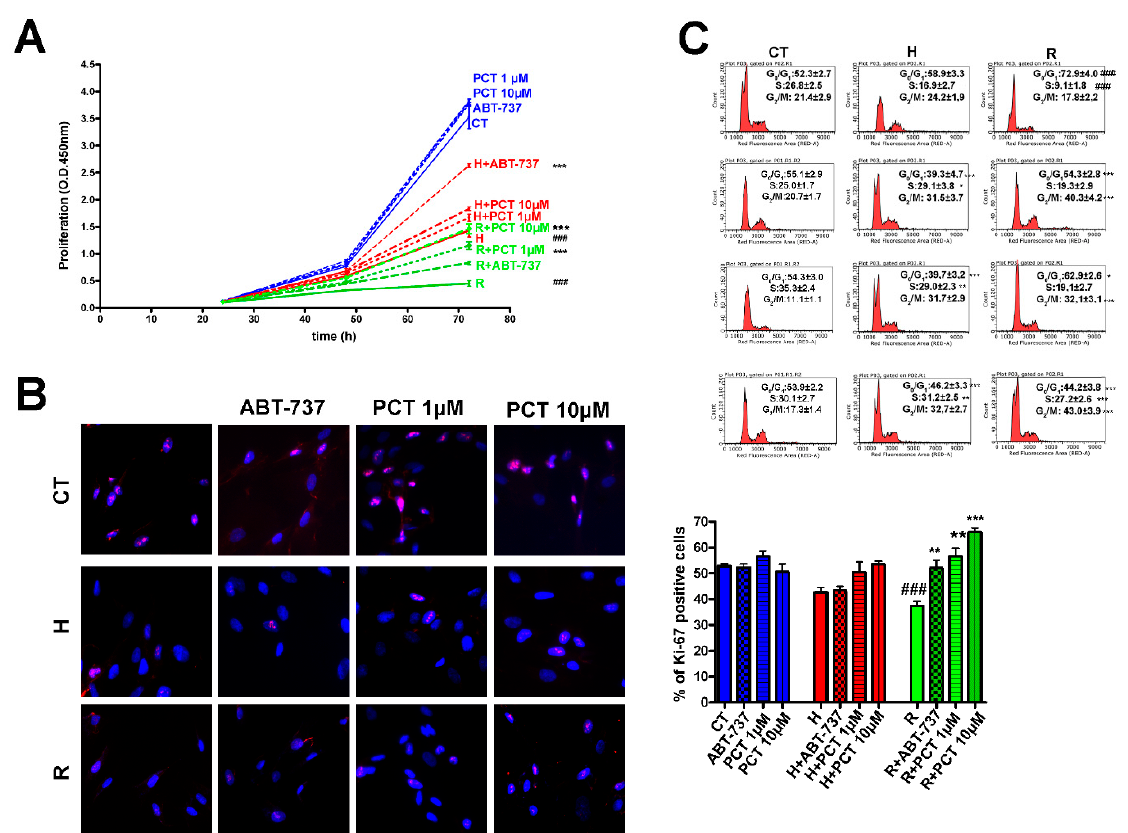
also determined in 30 DIV cultures. The pictures show representative images of beta-gal staining in control cultures at 10 DIV (CT), in 10 DIV samples treated with hydrogen peroxide (H), and in replicative senescent cultures at 30 DIV (R). The chart on the right shows the percentage of senescent cells in healthy cells (CT) treated with ABT-737 or PCT (blue bars), in peroxide hydrogen-treated cultures (red bars) and in replicative senescent cultures (green bars). Panel ( B ): Apoptosis levels were detected in control cultures at 10 DIV (CT), in 10 DIV samples treated with hydrogen peroxide (H), and in replicative senescent cultures at 30 DIV (R). The picture shows the flow cytometry chart of annexin V assay to detect apoptosis. The chart on the right shows the percentage of apoptotic cells in healthy cultures (CT) treated with ABT-737 or PCT (blue bars), in peroxide hydrogen-treated cultures (red bars) and in replicative senescent cultures (green bars). Data are shown with standard deviation (SD) n = 3. The ### p < 0.001 and ## p < 0.01 are the statistical significances between control (CT) and peroxide hydrogen treated samples (H) or replicative senescent cultures (R). The *** p < 0.001 and ** p < 0.01 are statistical significances between control and treated samples.